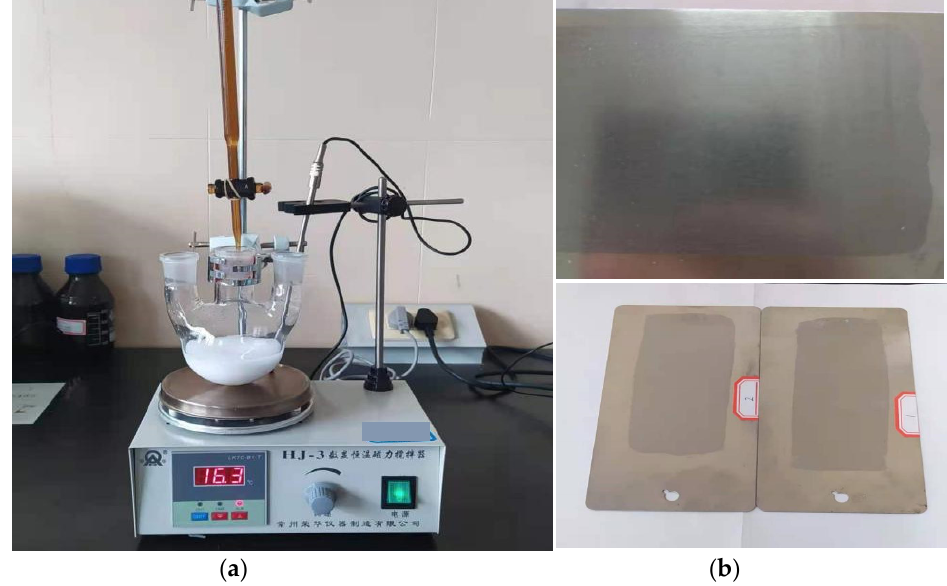
Figure 1. Laboratory set-up: ( a ) MoO 3 synthesis set-up and ( b ) MoO 3 /WEP coating sample.